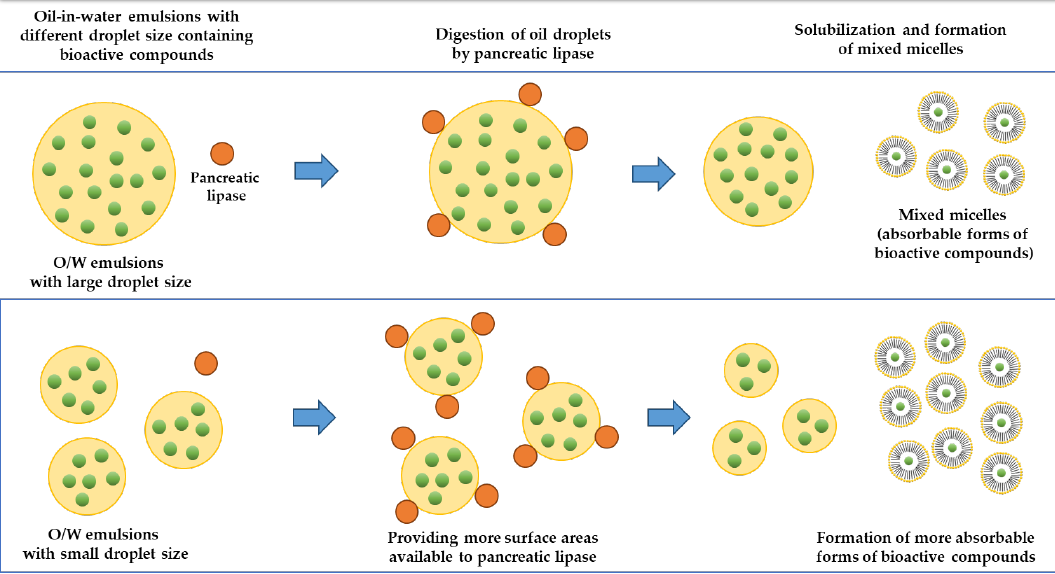
Figure 4. Illustration of the impacts of droplet size on the digestion of oil droplets and bioaccessibility of bioactive compounds encapsulated in oil-in-water emulsions. Adapted and modified from Zou et al. [73].